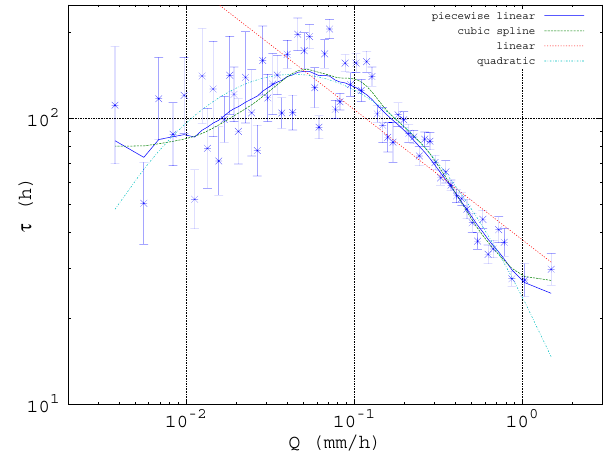
Fig. 4. Different functional fits to the binned mean recession time τ vs. Q for the example site. The piecewise linear fit is the same as that shown in Fig.